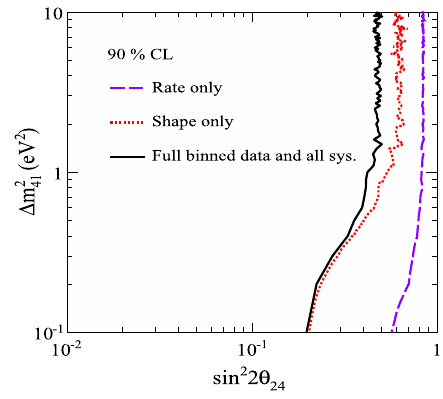
− sin 2 2 θ 24 plane 41